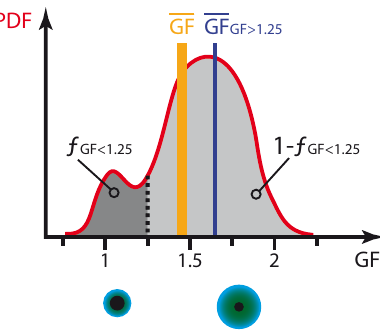
Fig. 1. Schematic growth factor probability density function (GF- PDF, red curve) obtained after the inversion of HTDMA data. The total area under the GF-PDF (dark grey plus light gray area) is unity by definition. The mean GF of the GF-PDF, GF, is indicated by the orange vertical line. The number fraction of the less hygroscopic particles with GF ≤ 1.25, f GF < 1 . 25 , is indicated by the dark grey shading, and the mean GF of all more hygroscopic particles (i.e. all those with GF > 1.25 , light grey shading), GF GF > 1 . 25 , is indicated by the vertical dark blue line. For illustration, a less hygroscopic particle with an insoluble core and a thin layer of water as well as a more hygroscopic particle with a small insoluble core with a thick layer of aqueous solution are shown at their approximate position below the GF